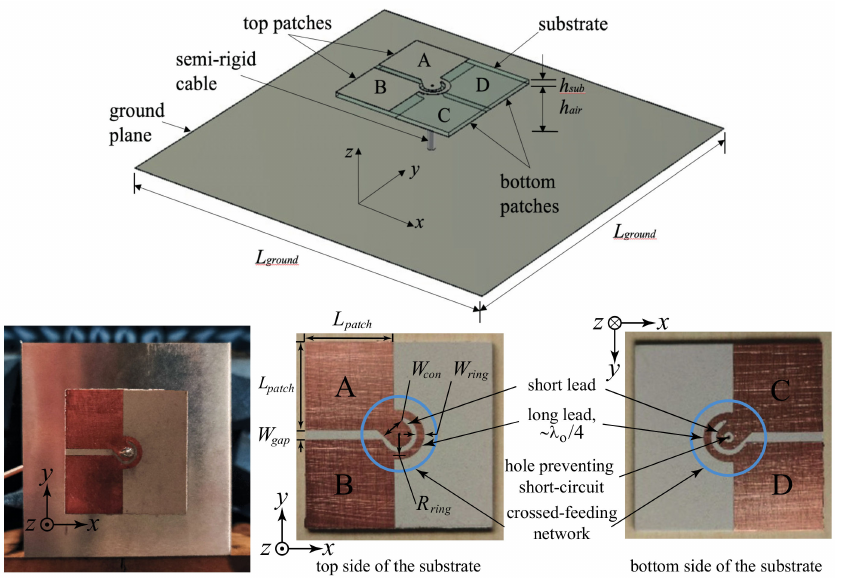
Figure 1. Geometry and fabricated prototype of the wideband CP cavity-less ME dipole antenna. L ground = 80.0, h sub = 1.27, h air = 17.7 (0.24 λ 0 ), L patch = 18.5, W gap = 2.1, R ring = 5.2, W ring = 1.5, W con = 5.2. All dimensions are in